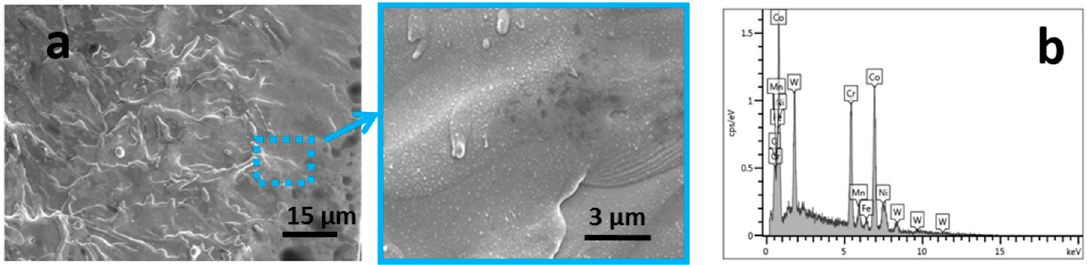
Figure 5. ( a ) The image of the argon cuts with acid pickling; ( b ) energy dispersion spectrum (EDS).